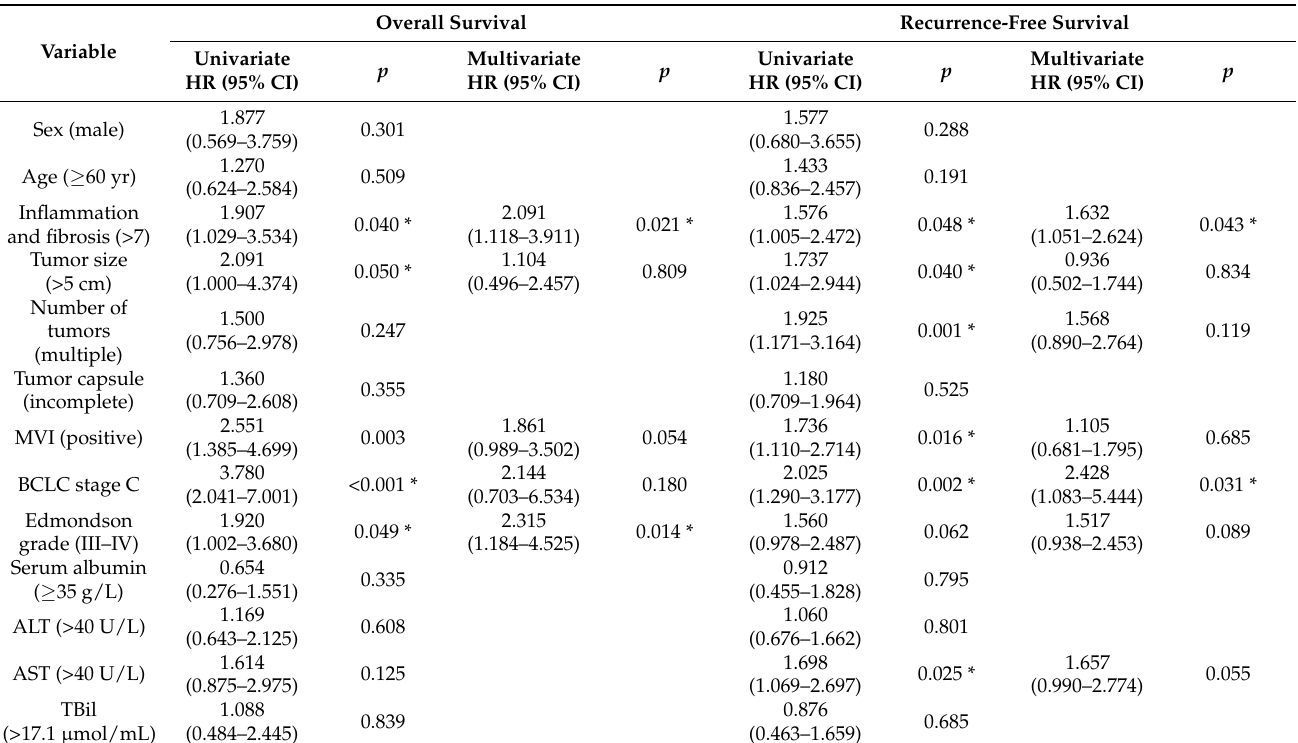
Table 5. Uni- and multivariate analyses to identify predictors of recurrence-free and overall post- hepatectomy survival of patients with non-cirrhotic hepatis B-associated HCC, after propensity score